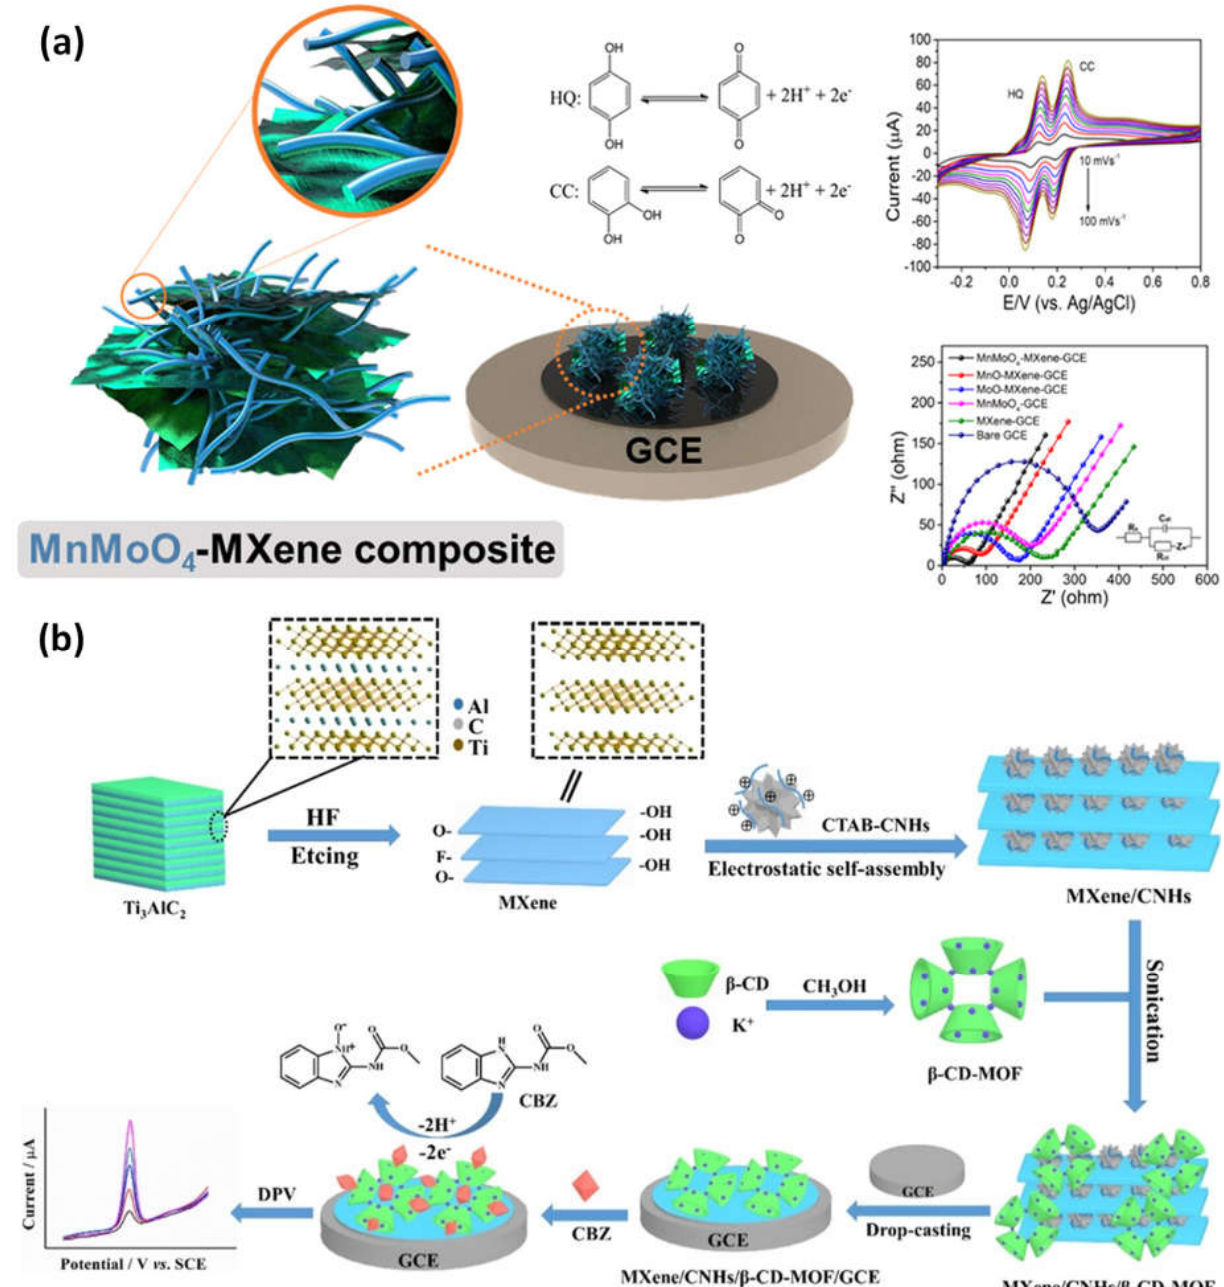
Figure 7. ( a ) Examples of the production of a 1D/2D MnMoO 4 /MXene nanomaterial sensing for the simultaneous detection of catechol (CC) and hydroquinone (HQ), as well as EIS and DPV responses to different concentrations of HQ and CC in MXene nanocomposite materials; ( b ) based on the MXene-CNHs-CD-MOF electrode, an electrochemical sensor for the detection of carbendazim was developed. Reproduced with permission from references [77,79].